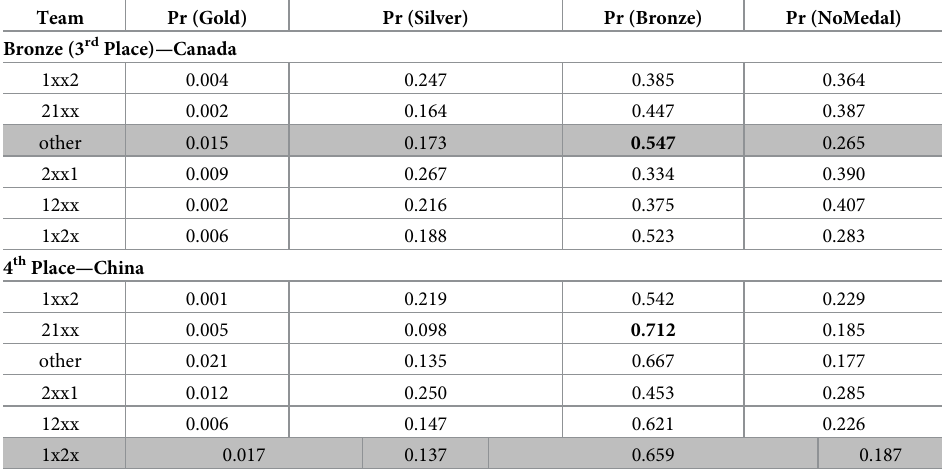
Table 5. Effect of team order on the probability (Pr) of Gold, Silver, Bronze or no medal for Canada and China who finished 3rd and 4th, respectively, in the women’s 4 x 200-m freestyle relay at the 2019 FINA World Championships.